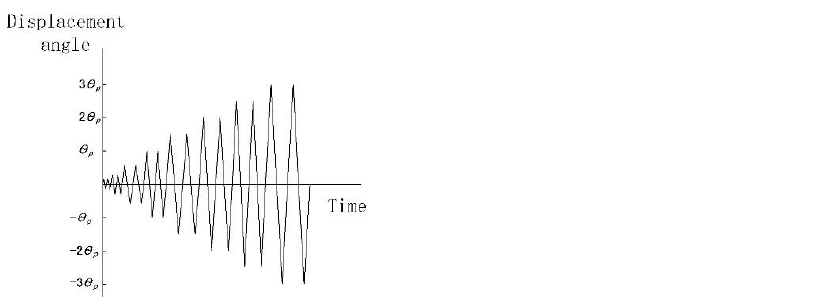
Figure 4. The loading device.